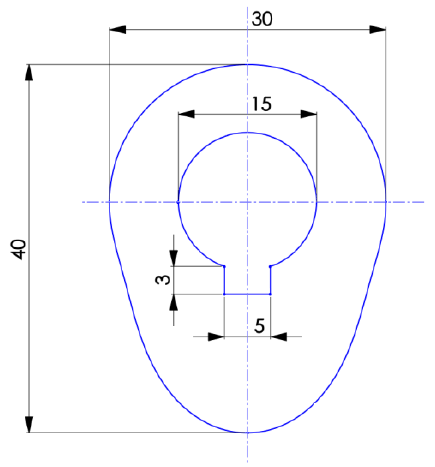
Figure 5. Geometry and final dimensions of the radial cam employed in the wear tests, where the dimensions are expressed in mm.